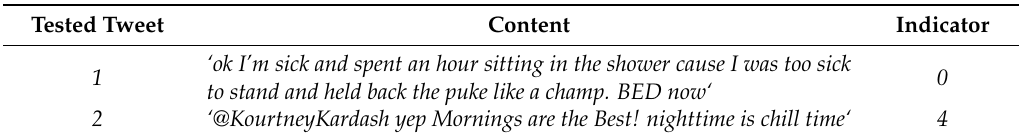
Table 3. Two examples of tested tweets.